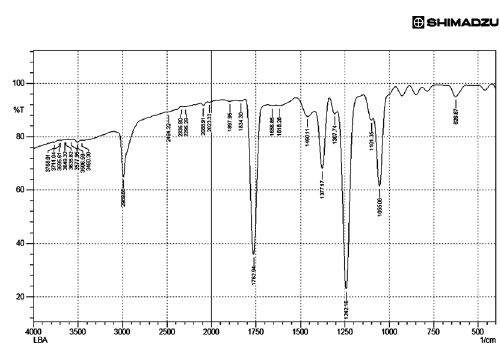
Fig. 6. FT IR Spectrum of active ethyl acetate extract of Streptomycetes cavourensis SKCMM1 fermented